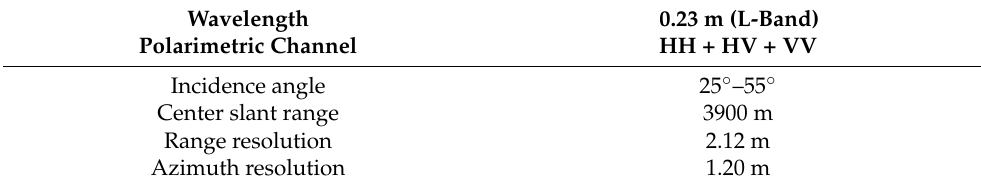
Table 4. The parameters of the E-SAR airborne system.